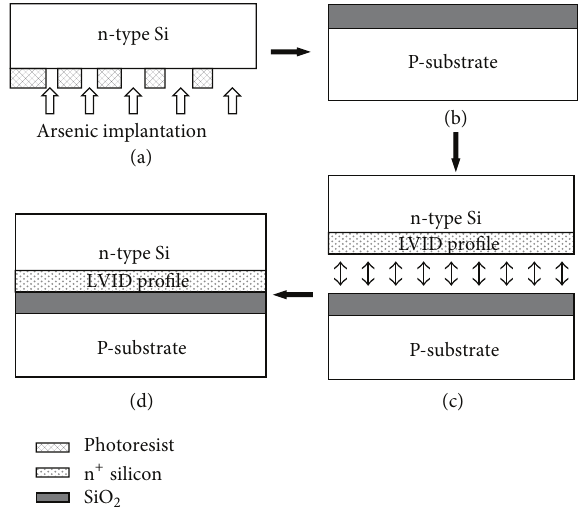
on BV and 𝑅 on , lvid